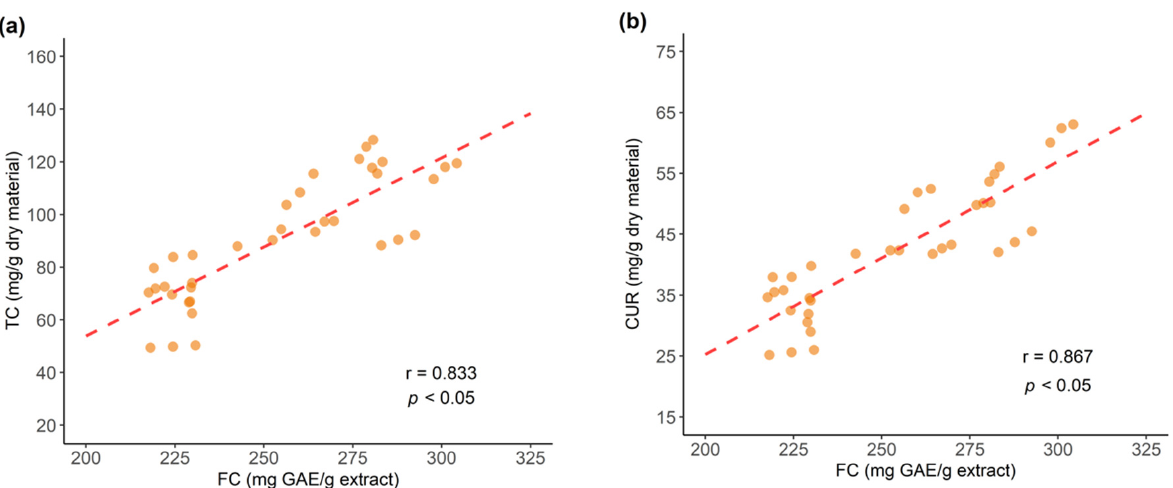
Figure 15. Correlation of Folin–Ciocalteu (FC) reducing capacity results and: ( a ) UPLC-DAD total curcuminoids (TC), ( b ) UPLC-DAD curcumin (CUR) contents.